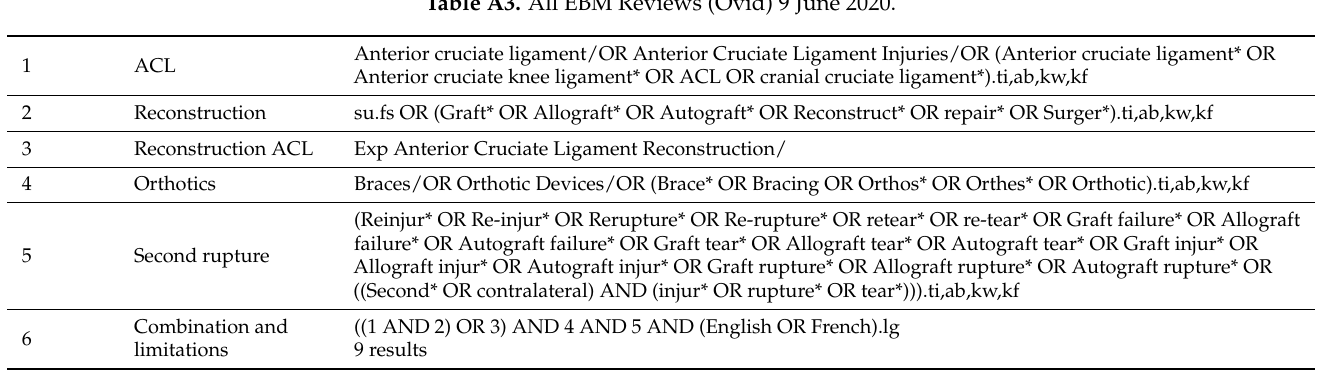
Table A3. All EBM Reviews (Ovid) 9 June